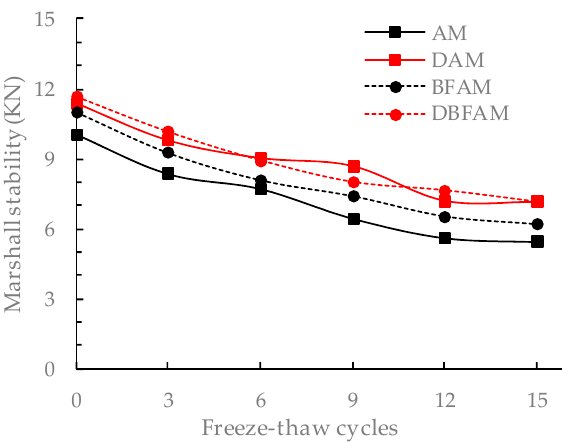
Figure 15. Marshall stability under freeze–thawcycles.